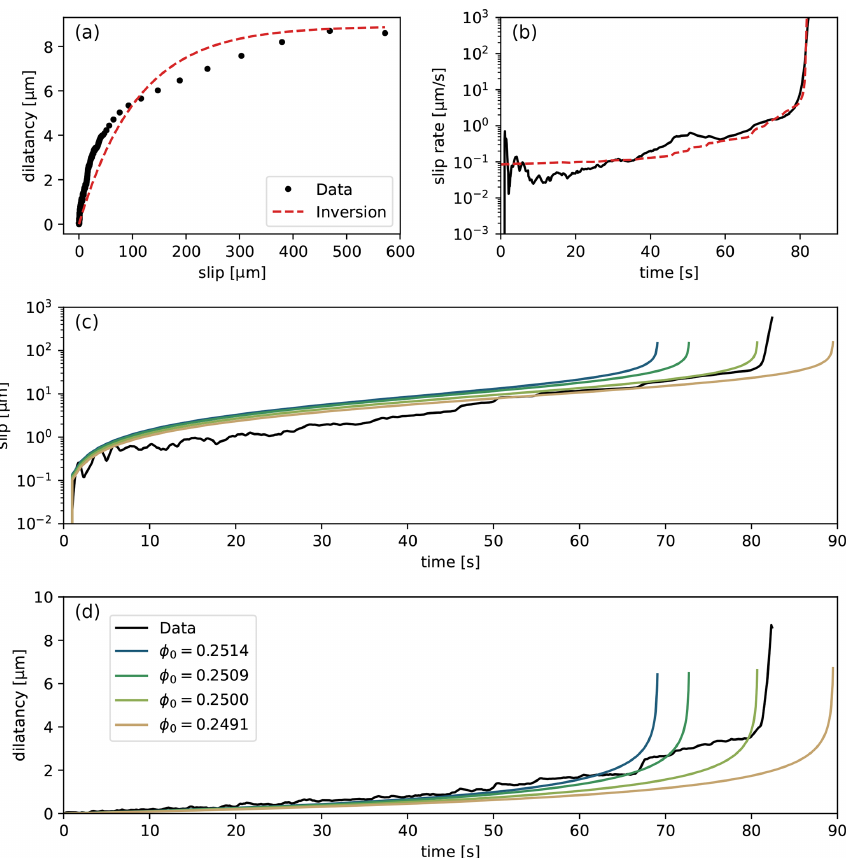
Figure 4. Results of the inversion procedure. (a) Dilatancy versus slip, with the inversion curve given by Eq. (6); (b) slip rate versus time, with the inversion curve given by Eq. (1a); (c, d) forward model results of slip and dilatancy for a (narrow) range of initial porosity φ 0 (as indicated in the legend). The reference value of φ 0 is obtained from the inversion of Eq.